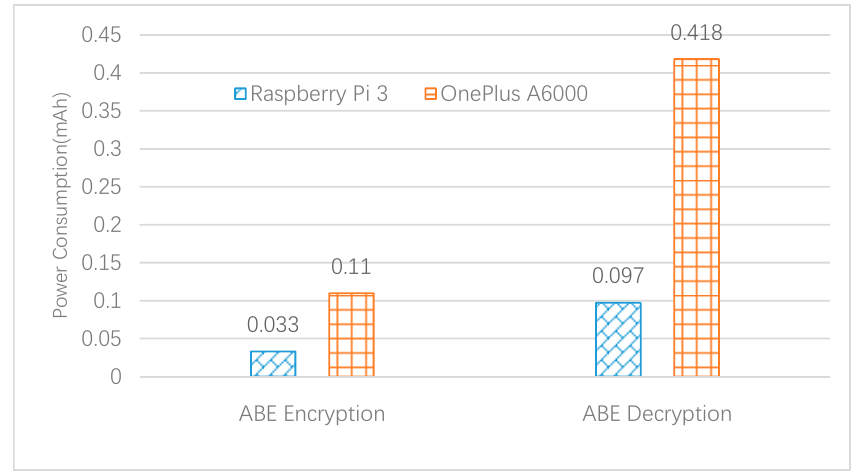
Figure 9. ABE algorithms’ energy consumption on Raspberry Pi 3 and OnePlus A6000 smartphone.